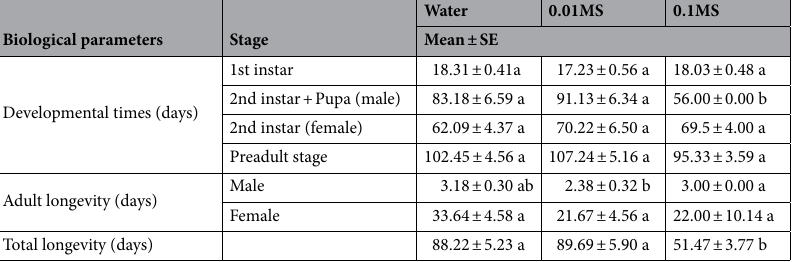
Table 1. Developmental duration, adult longevity, and total longevity of Acanthococcus lagerstroemiae reared on Lagerstroemia under different nutrient conditions. Values are means ± standard errors; data within a row followed by different letters are significantly different at p < 0.05 by using paired bootstrap test.